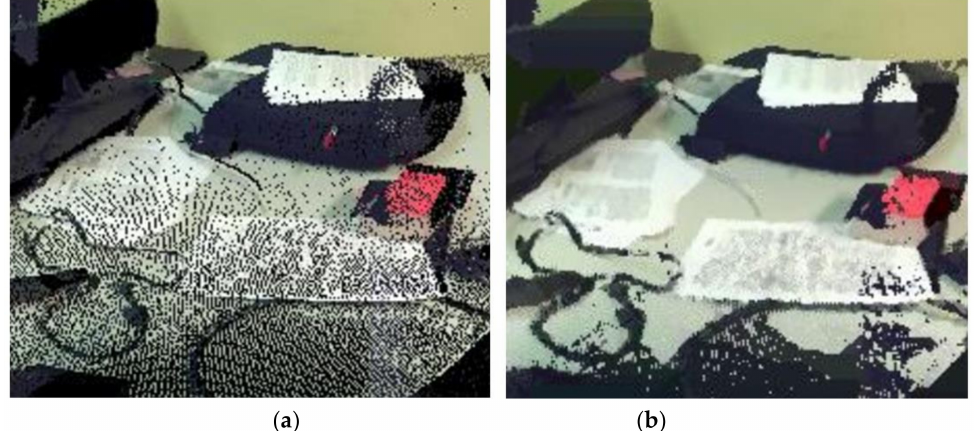
Figure 23. Recovery of writings on papers: ( a ) before image processing; ( b ) after image processing.